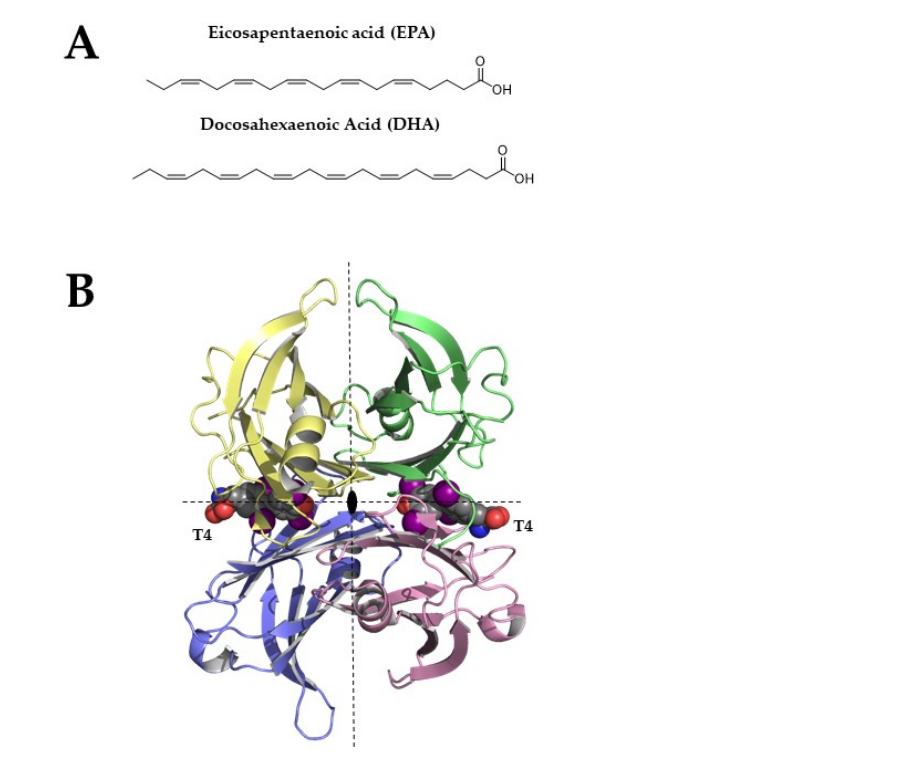
Figure 1. ( A ) Chemical structures of EPA and DHA ( B ) Tetrameric structure of TTR (pdb structure 1sn0), two thyroxine molecules bind the TTR-binding sites. Structural figures were made by PyMOL using our scripts [13–15].